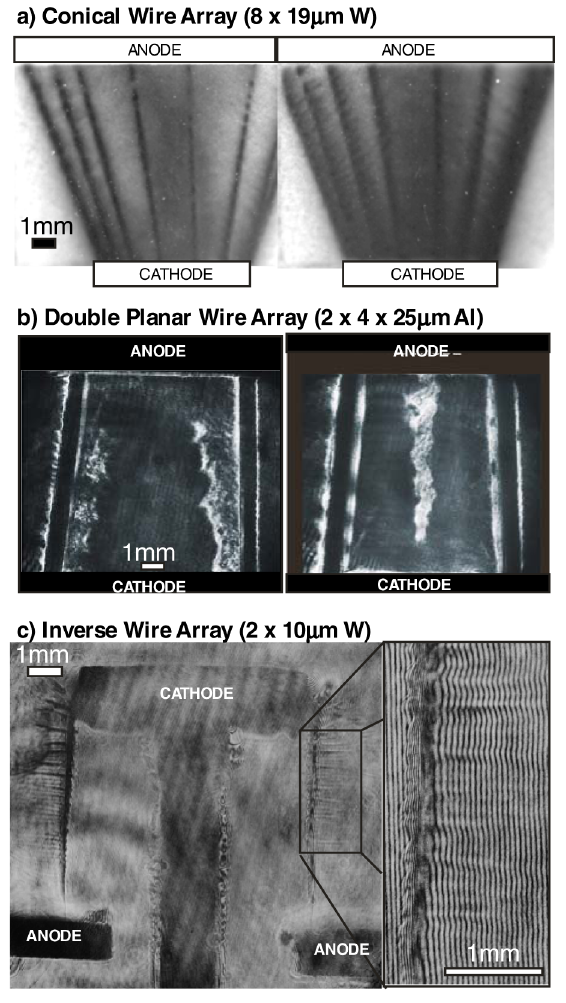
FIG. 7. Examples of results on the 200 kA GenASIS machine: (a) conical wire array, (b) double planar wire array, and (c) inverse wire array.